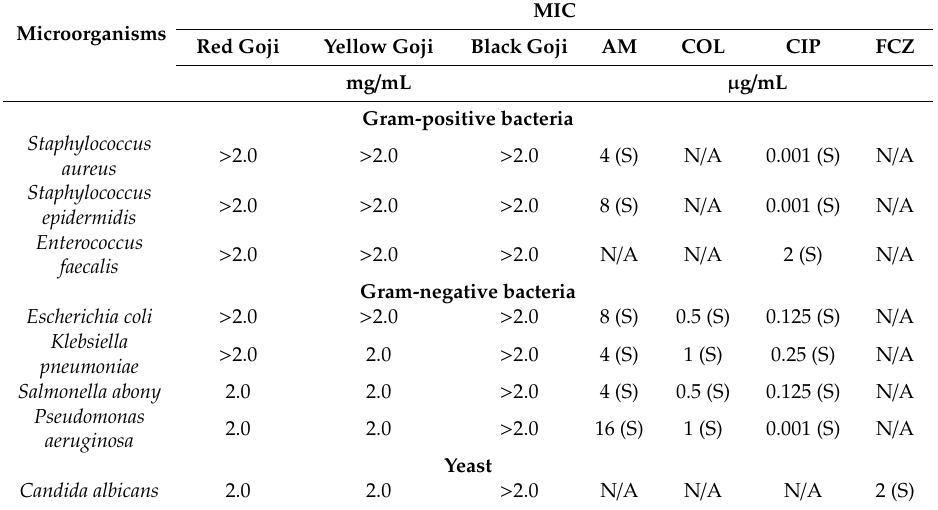
Pseudomonas aeruginosa Candida albicans